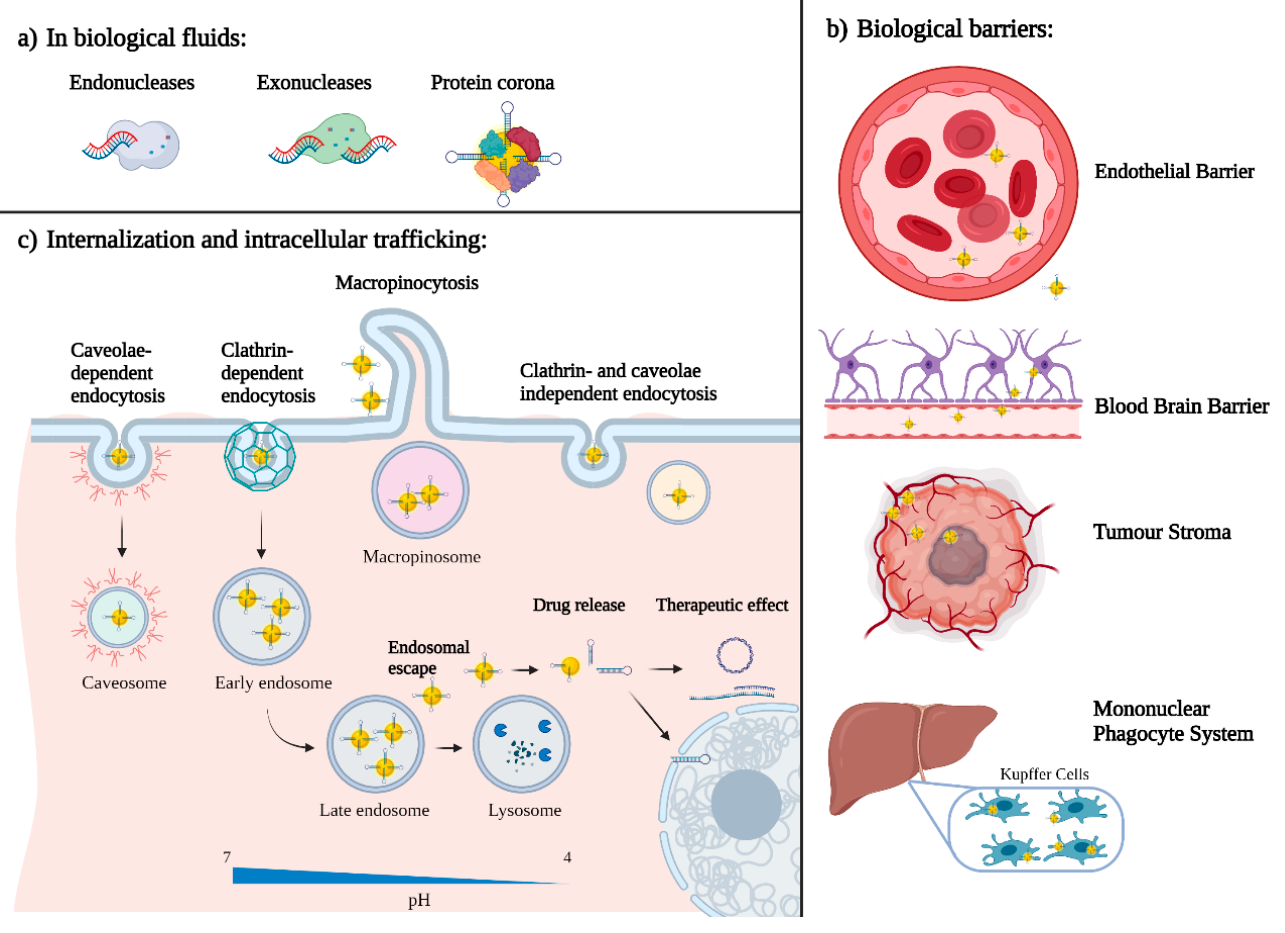
Figure 3. Biological barriers for nanotechnology-based gene delivery systems: ( a ) at the organ/tissue level, ( b ) at the mo- lecular level ( c ) and at the cellular level.